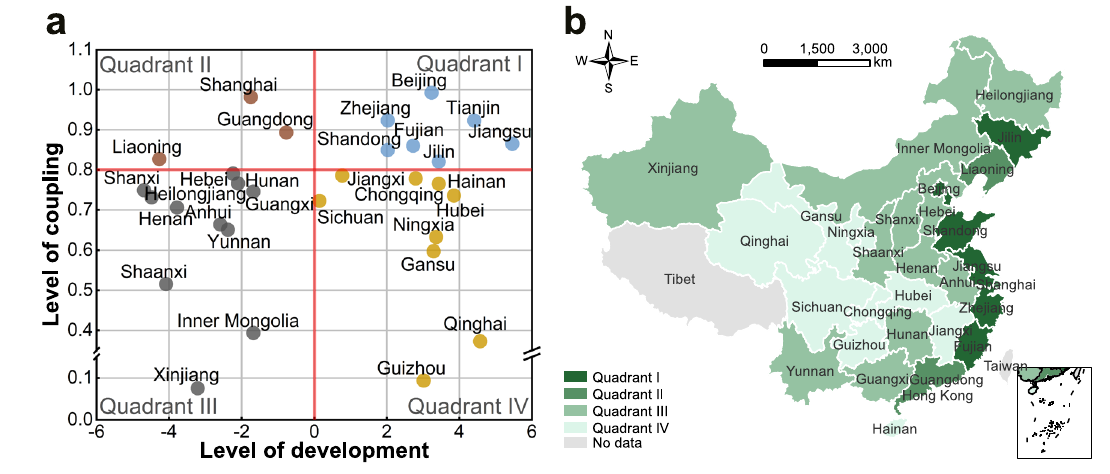
Fig. 7 | Development patterns of China ’ s provinces from 2000 to 2018. a The performance relative to the levels of coupling ( y -axis) and development ( x -axis). b Spatial patterns. The level of coupling represents the magnitude of CCD (i.e.,